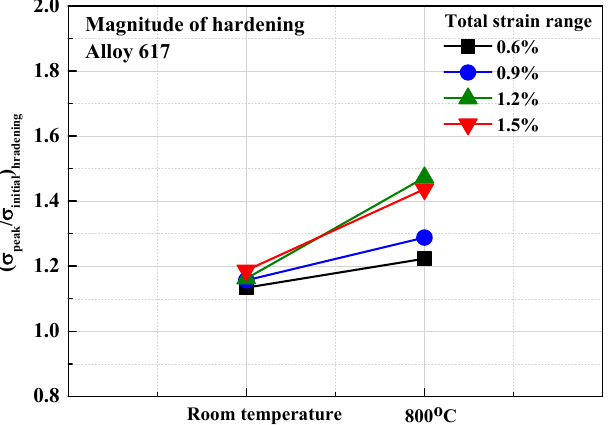
Figure 7. The comparison of ratio of cyclic stress amplitude as a magnitude of hardening of Alloy 617 weldments at room temperature and 800 °C.